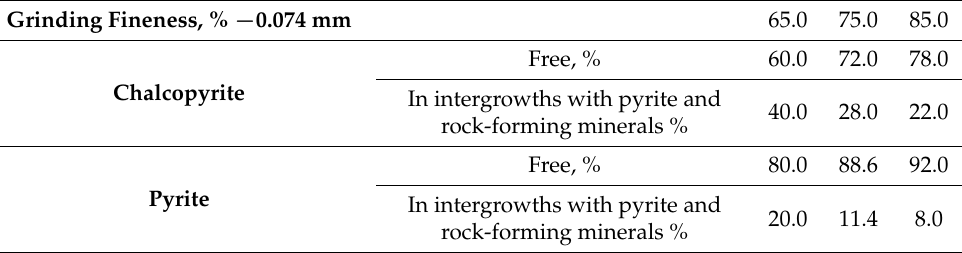
Table 1. Degree of chalcopyrite and pyrite release in the original ore at different grinding